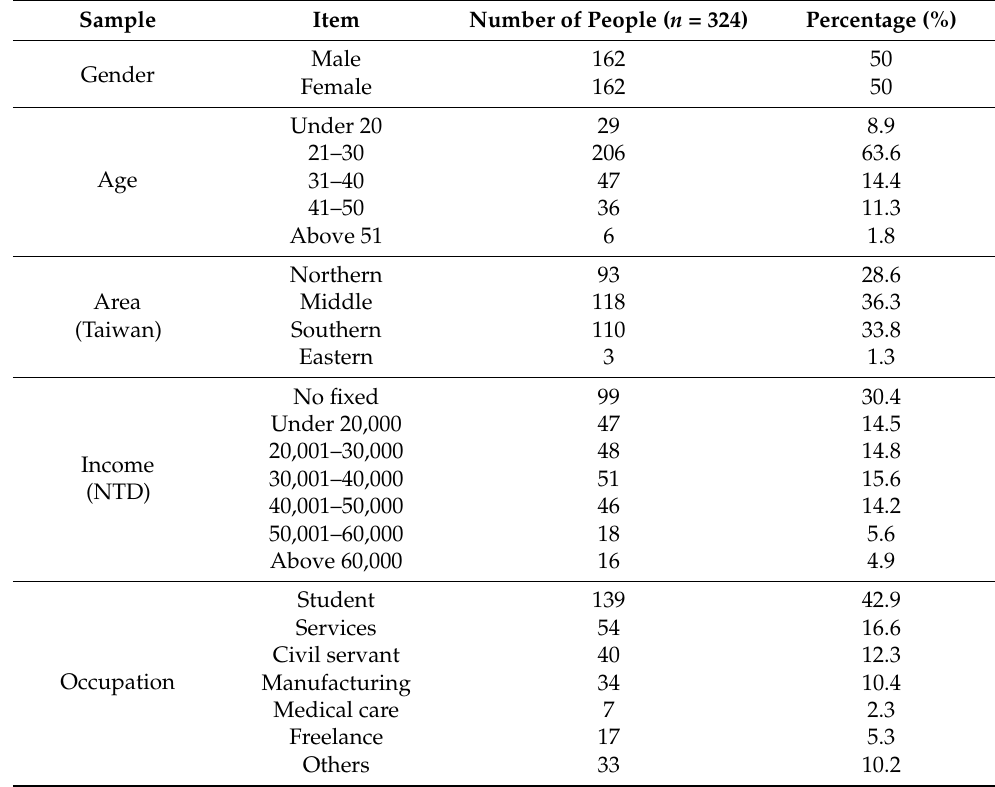
Table 3. Descriptive analysis of demographic variables of respondents.